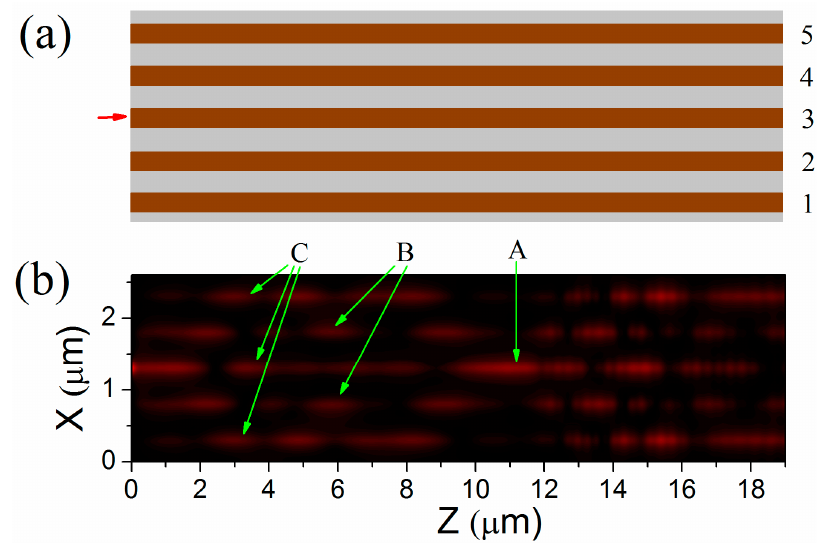
Figure 2. ( a ) The arrangement of five HPWs in xz plane. ( b ) The propagation behavior of SPPs in five HPWs.